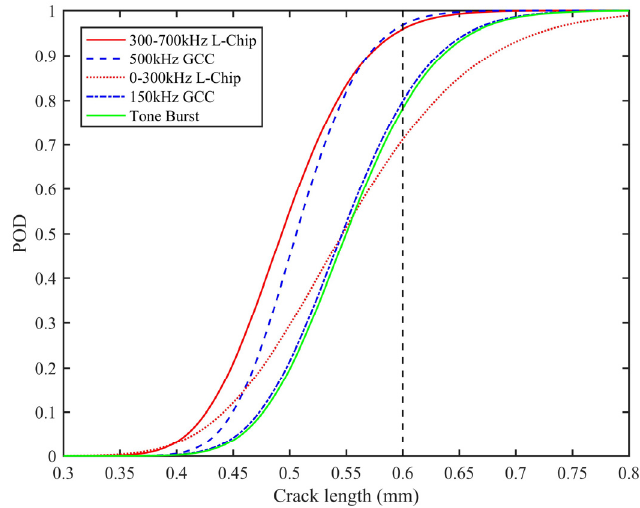
Figure 14. POD curves of different excitations.